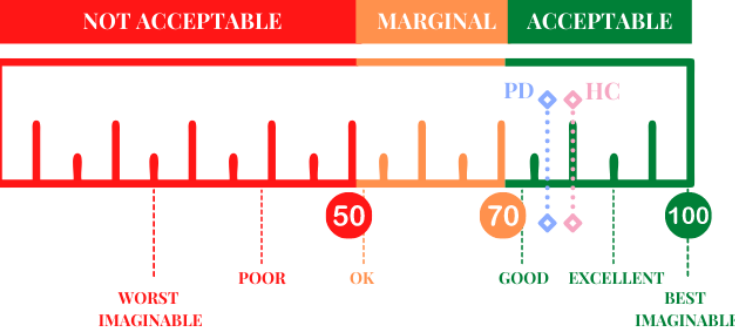
Figure 5. A graphic representation of the SUS score. PD, Parkinson’s disease; HC, healthy control. Specifically, according to the cut-off score (cut-off = 68), more than 74% of PwPD and 92% of HC showed scores above the cut-off. In addition, according to the adjective rating, 29.6% of subjects evaluated EXIT 360° as “OK”, 59.3% as “good”, 7.4% as “excellent”, and 3.7% as “best imaginable” [51,58]. As regards HC, 3.7% of subjects evaluated EXIT 360° as